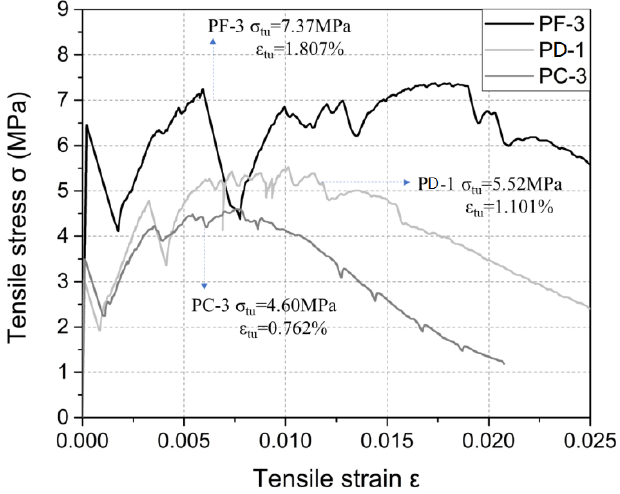
Figure 12 . Tensile stress-strain curve of different specimens. Figure 12. Tensile stress-strain curve of different